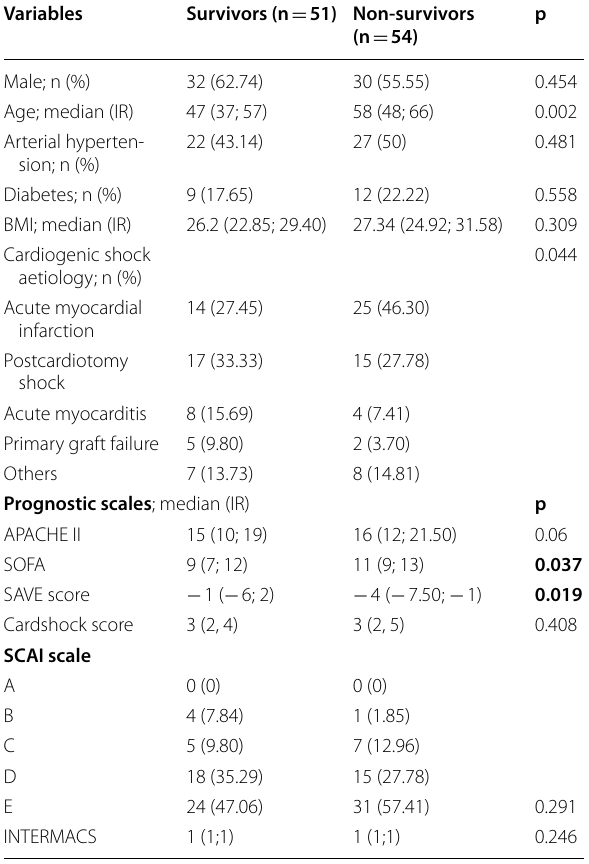
Table 1 Analysis of demographic characteristics, history, etiology of cardiogenic shock and prognostic scales according to mortality. BMI, body mass